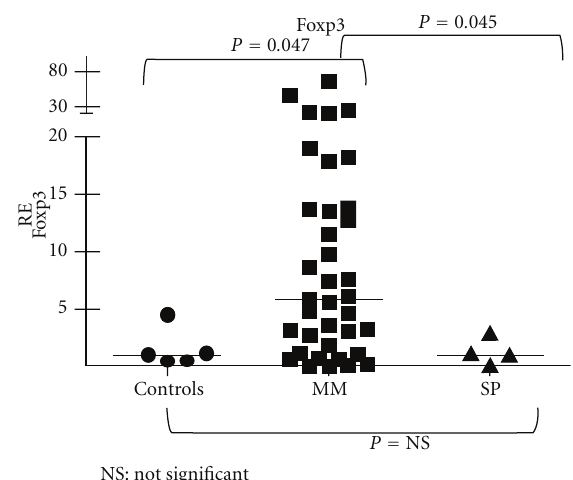
Figure 1: Relative expression (RE) of Foxp3 in bone marrow aspi- rates of myeloma, solitary plasmacytomas, and normal controls.